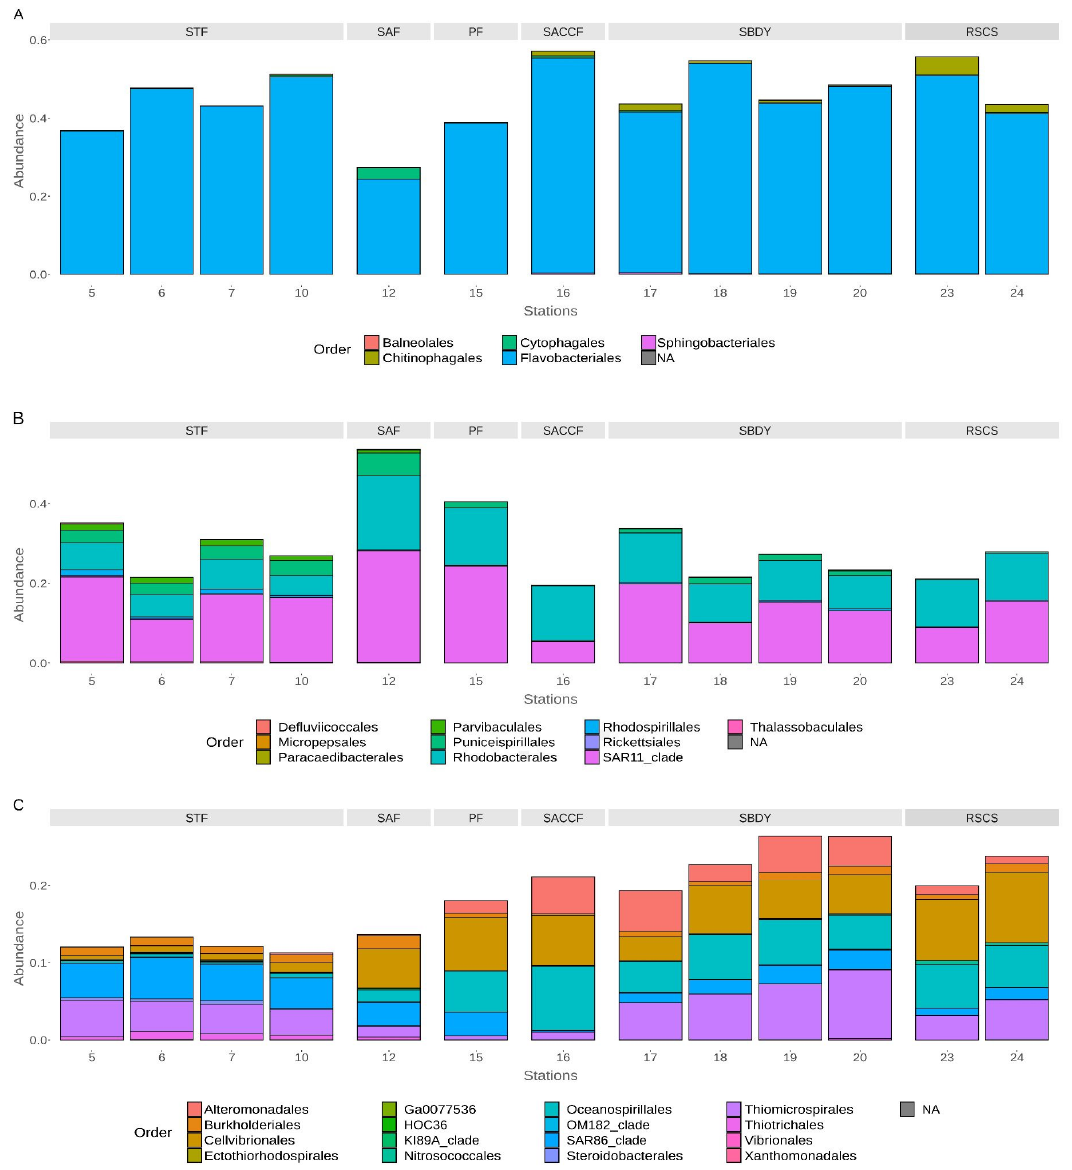
Figure 3. Order level distribution of the 16S rRNA diversity within the classes Bacteroidia ( A ), Alphaproteobacteria ( B ) and Gammaproteobacteria ( C ) for the stations.